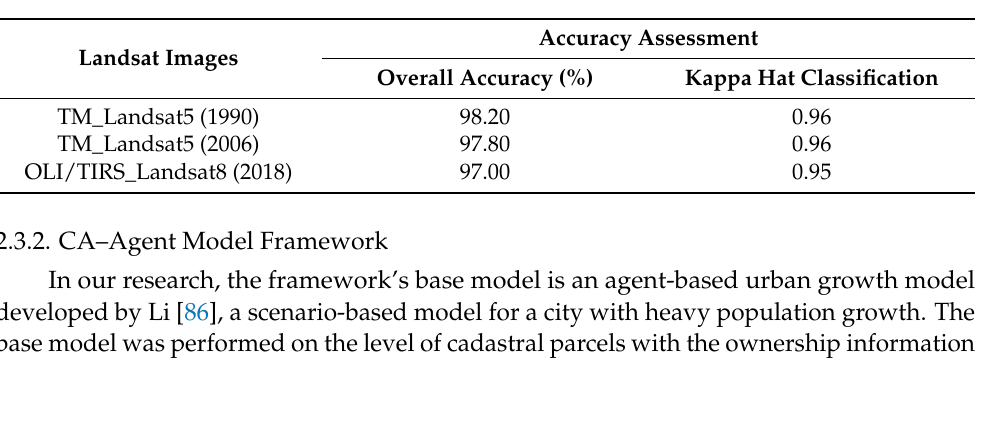
Table 2. Statistical results of classification accuracy